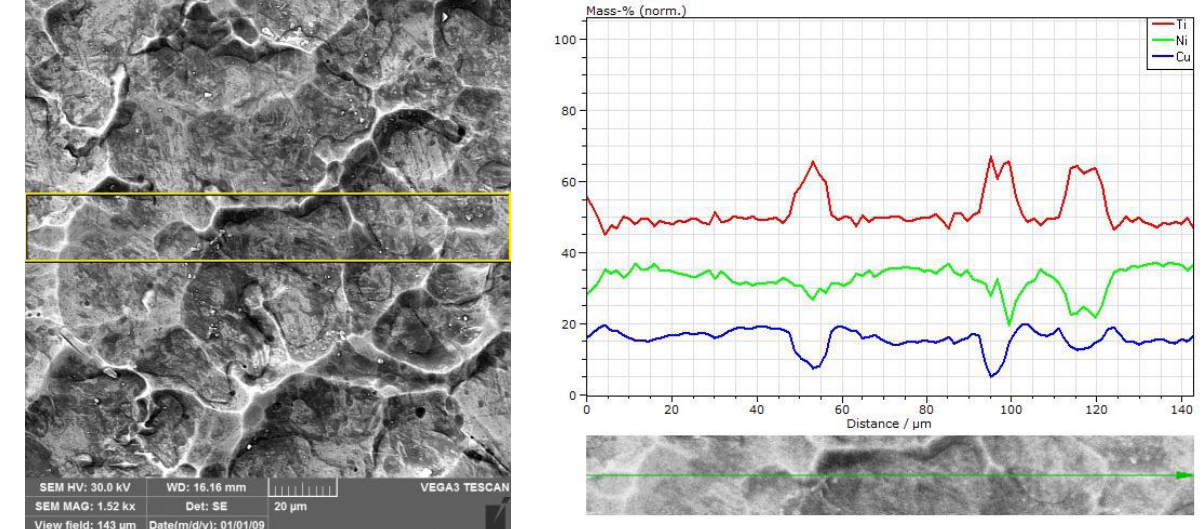
Figure 1. ( left ) Microstructure and (upper ( right )) compositional map of the Ti-Ni-Cu target alloy; the investigated area is marked by ( left ) a rectangle and by (lower ( right )) a double-ended arrow. Further compositional analysis along the surface indicates strong variation in the grain boundaries compared to the one determined inside the grains. Thus, an increase in the Ti content in the grain boundary and, as shown in Table 2, a decrease in the Cu and Ni content in the same area were detected. Whereas the composition inside the grain is closer to the overall composition of the target, in what concerns the grain boundaries, the situation